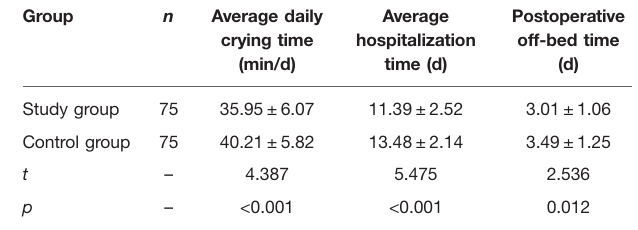
TABLE 4 | Comparison of PSQI scores between two groups of children before and after nursing ( (cid:1) x + s, score). Group